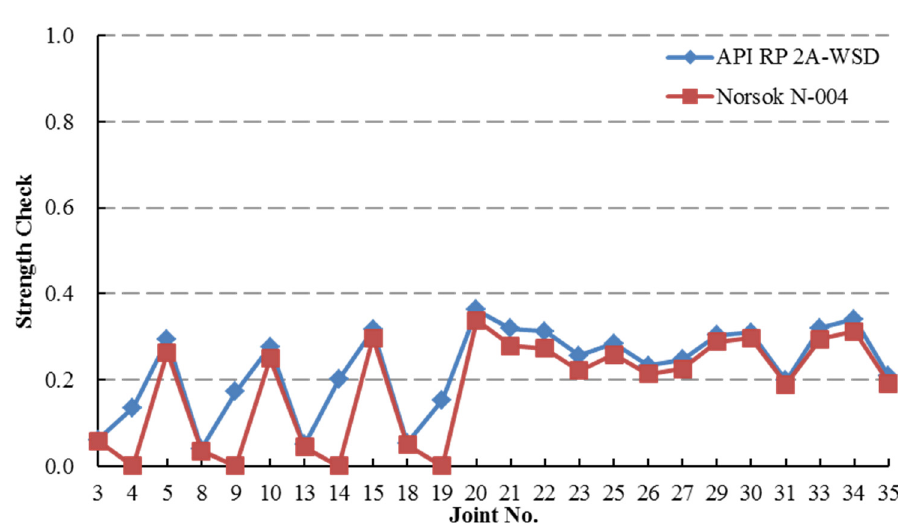
Figure 30. Joint Strength Check (Case 6).